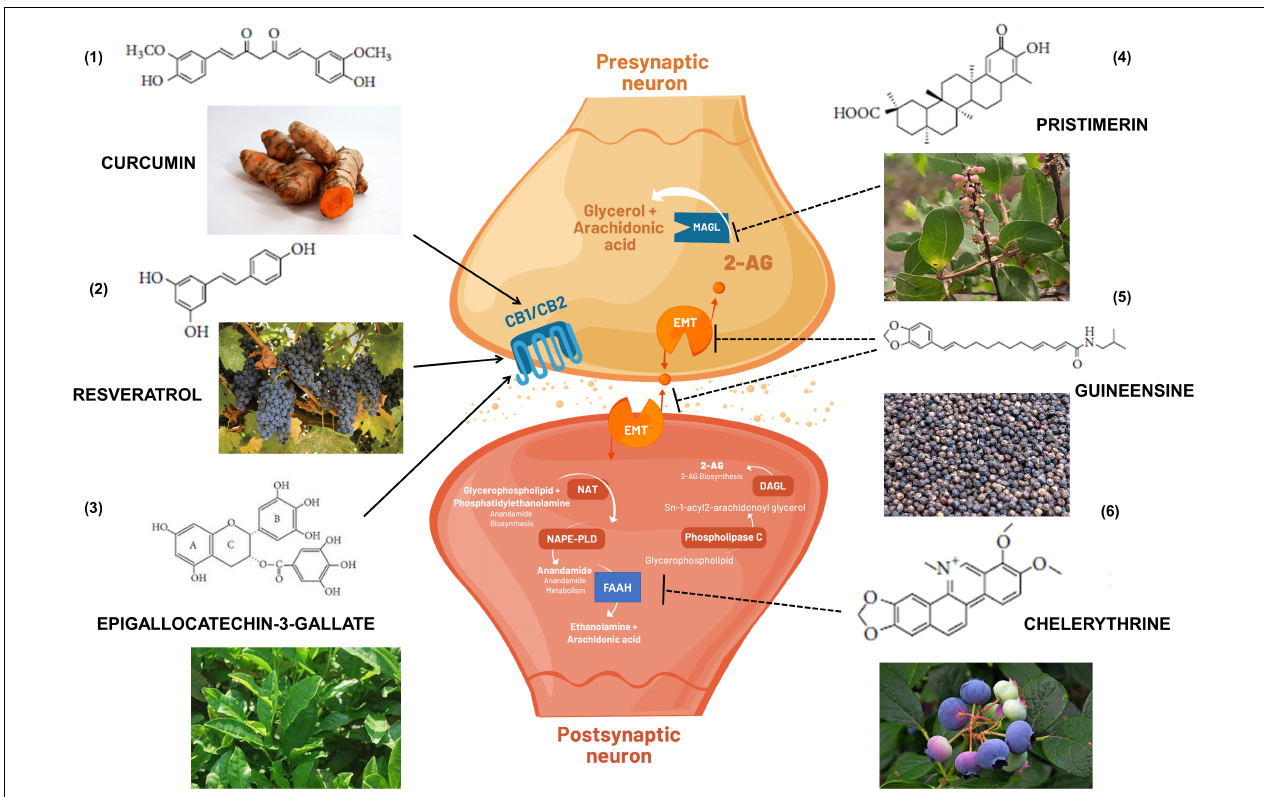
FIGURE 3 | Cannabimimetic activity of bioactive substances obtained in foods and medicinal plants that if included in the diet could indirectly exert immunomodulatory and beneficial effects to the health. (1) turmeric root; (2) grapes; (3) green tea; (4) Maytenus senegalensis (Lam.) fruit and roots; (5) black peppers; and (6) blueberries. Arrows indicate activation of CB1 and/or CB2 receptors. Dashed arrows indicate inhibition of endocannabinoid transporters (EMT) or enzymatic metabolism via FAAH (Fatty acid amide hydrolase) or MAGL (Monoacylglycerol lipase). DAGL: Diacylglycerol lipase; NAPE-PLD: N-acyl phosphatidylethanolamine phospholipase D; NAT: N-acetyltransferase; 2-AG: